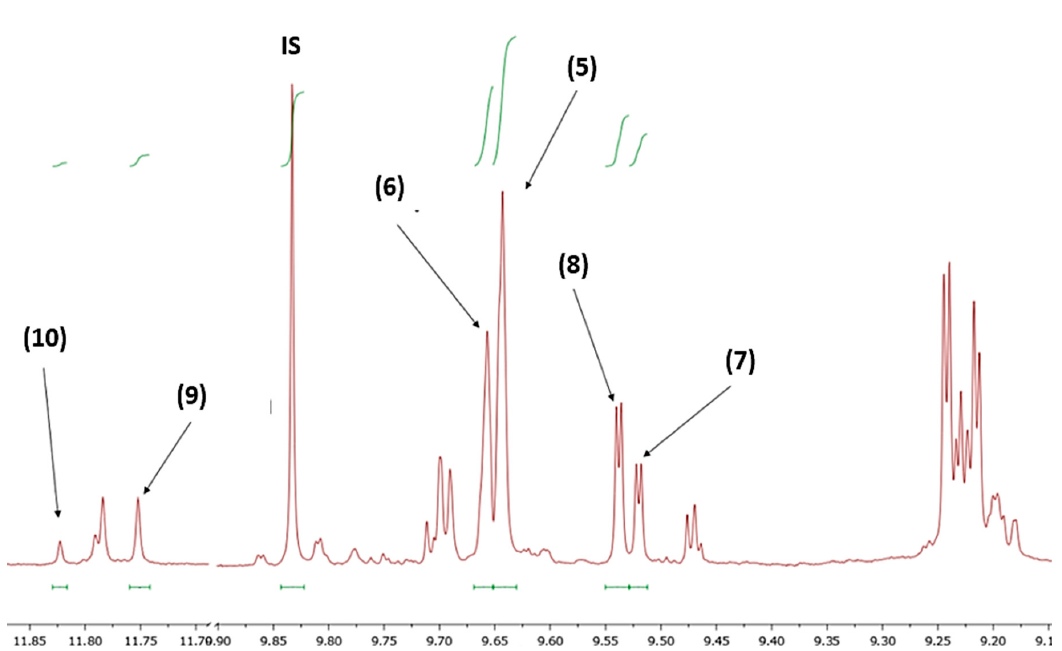
Figure 10. Example of NMR spectrum (400 MHz) of the aldehydic region of a typical olive oil extract depicting the selected peaks that were used for integration: oleocanthal ( 5 ), oleacein ( 6 ), ligstroside aglycon monoaldehydic form ( 7 ), oleuropein aglycon monoaldehydic form ( 8 ) oleokoronal ( 9 ), oleomissional ( 10 ). IS: internal standard (syringaldehyde).